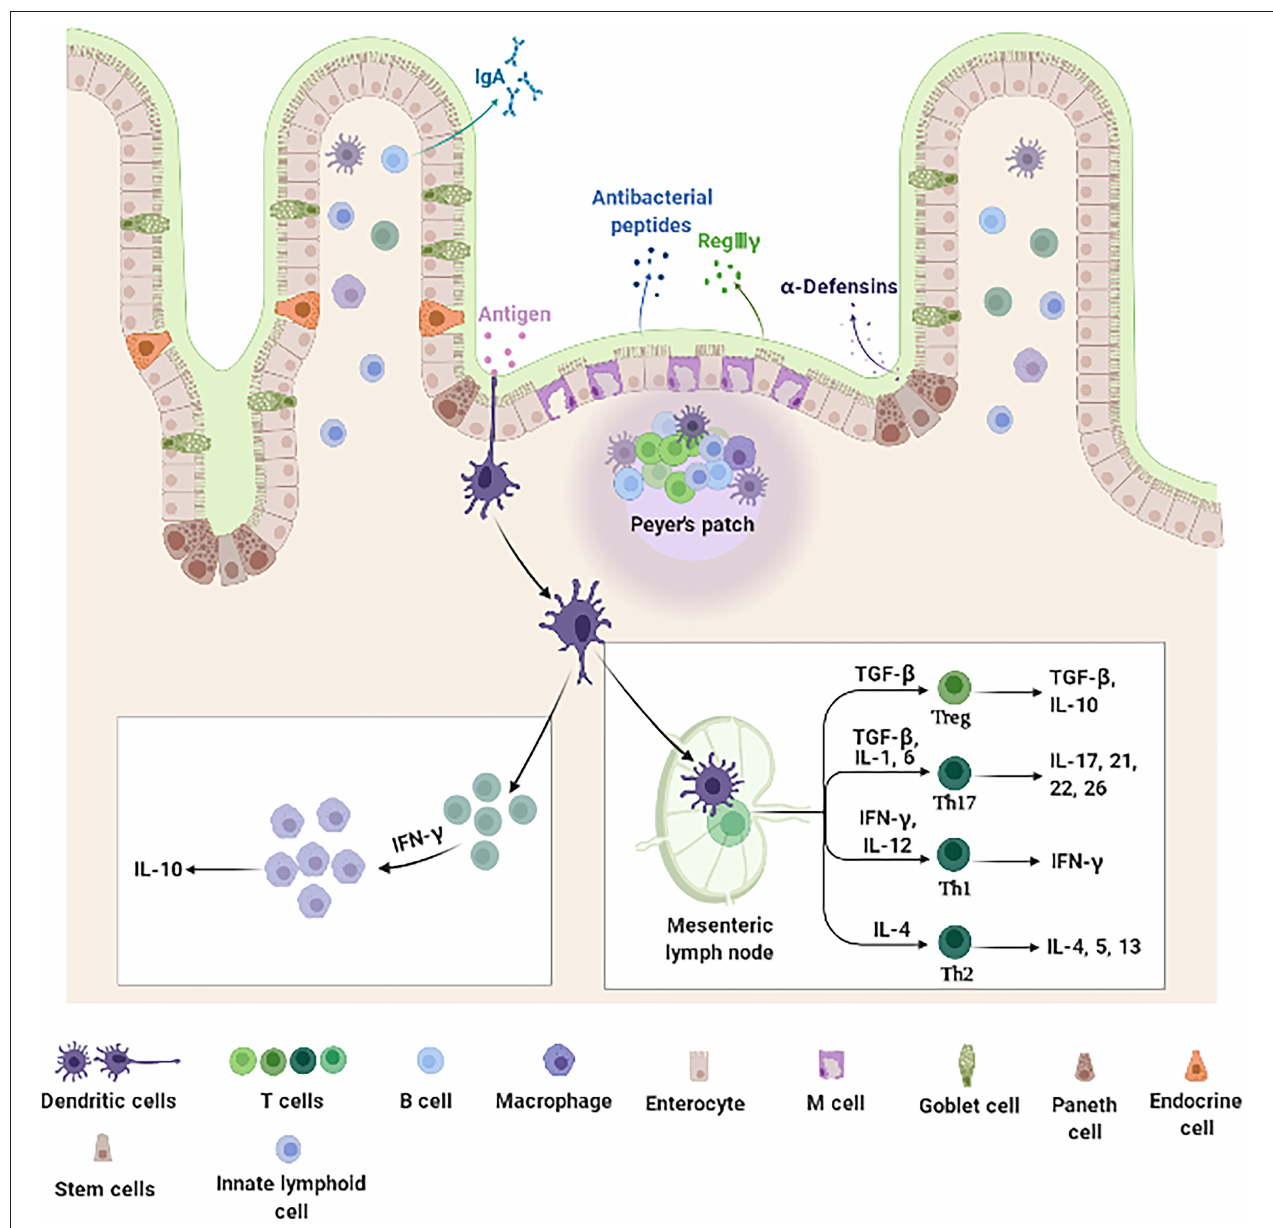
FIGURE 1 | Intestine mucosal immune system landscape. The intestine mucosal immune system is composed of different types of functional cells. Enterocytes, the main functional cells of intestine mucosal immune, are responsible for the absorption of nutrients and water, and also produce antimicrobial peptides (such as RegIII γ and β -defensin). Paneth cells located at the bottom of the crypt produce amounts of specific antimicrobial peptides ( α -defensin). M cells function to sample and transport antigens to immune cells. Goblet cells secrete mucins and promote luminal antigen transfer to DCs. In addition, there are a large number of immune cells distributed in the intestinal epithelium and LP, including DCs, B cells, and T cells. DCs are specialized antigen-presenting cells. After antigens stimulation, they secrete cytokine IFN- γ , which further stimulates monocyte macrophages to secrete IL-10. The DCs that migrate to the MLNs promote the differentiation and maturation of initial T cells. These differentiated and mature T cells can secrete immune factors to participate in intestine mucosal immune system. DCs, dendritic cells; IFN- γ , interferon- γ ; IL-10, interleukin-10; LP, lamina propria; M, microfold; MLNs, mesenteric lymph nodes; RegIII γ , regenerating islet-derived protein III γ .